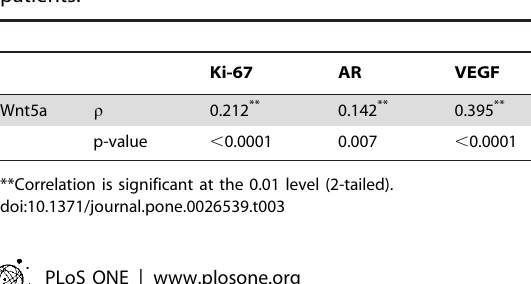
Table 3. Spearman’s correlation coefficients ( r ) when Wnt5a protein expression was analyzed for possible correlation with other tissue biomarkers in the cancer cores from 464 PCa